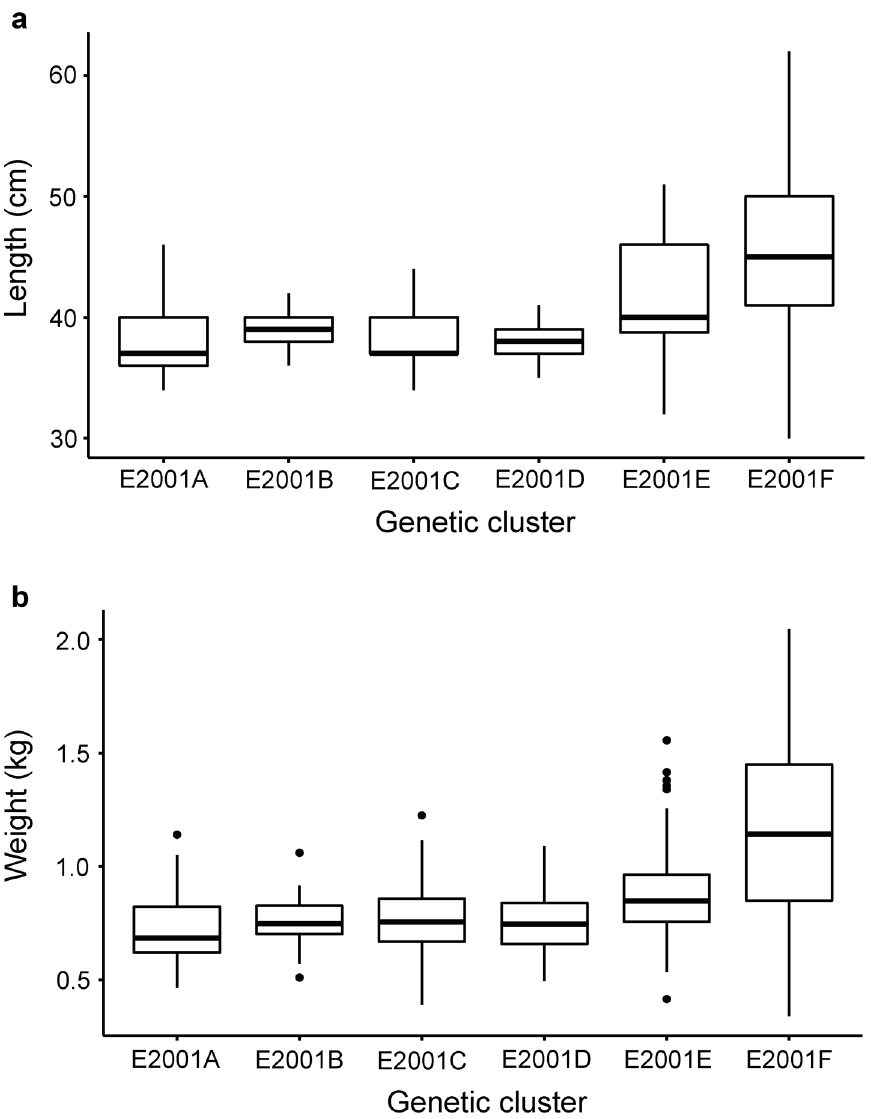
Figure 6. Box plots showing (a) length distribution, and (b) weight distribution in historical groups E2001A– E2001F. Black line in boxes indicates the